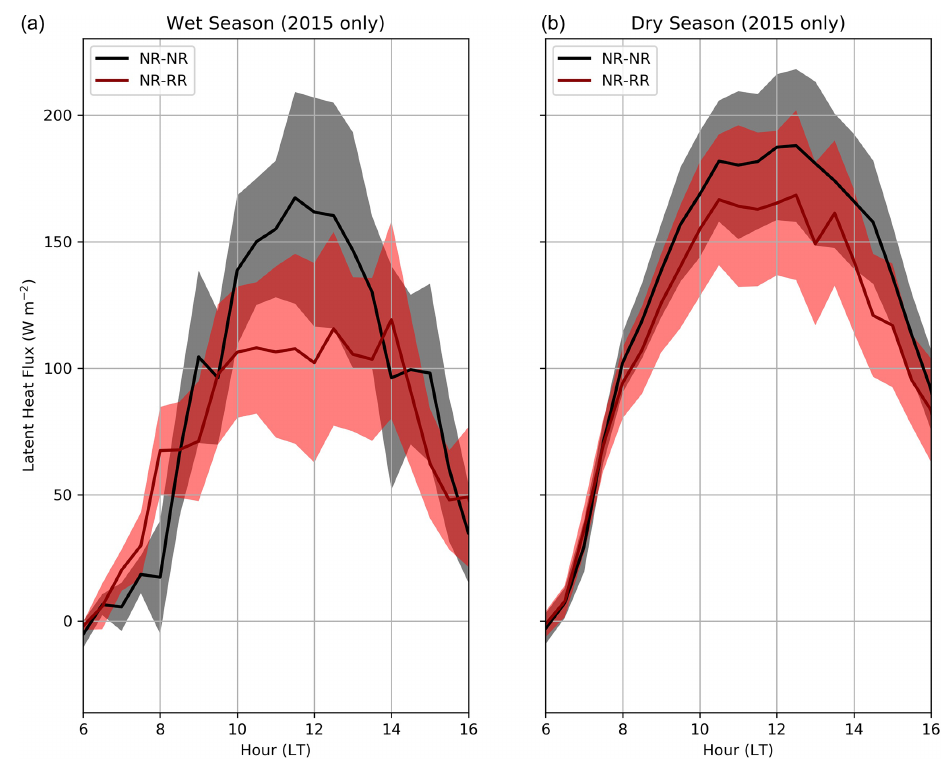
Figure 6. Mean (composite dataset) latent heat fluxes measured by ECOR for dry and wet seasons and NR–NR and NR–RR transitions. Shaded areas represent 1 standard